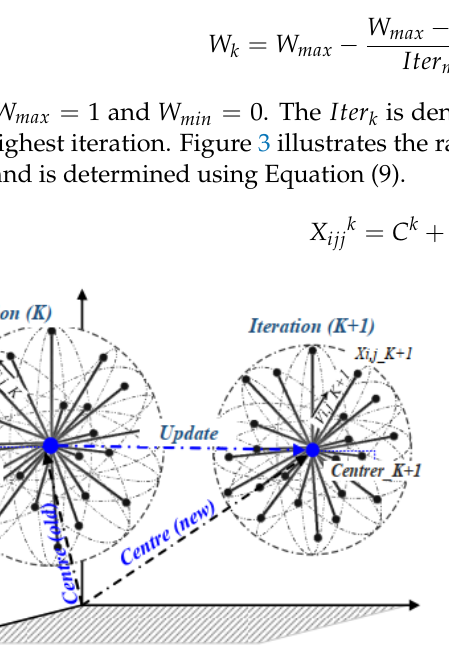
Figure 3. Center point updating process in two consecutive iterations.